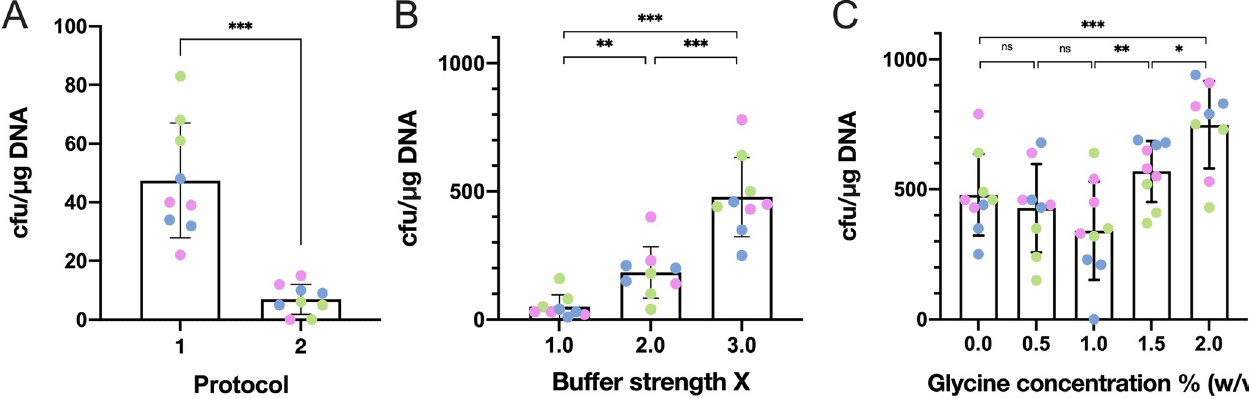
Fig 2. Optimization of competent cells preparation for L . jensenii ATCC25258 using pTRKH2. A. Comparison of widely used electroporation protocols for Lactobacillus spp . Shown are transformation efficiency of Lactobacillus jensenii observed using original protocols described by Luchansky et al. (protocol 1) [22] and Berthier et al. (protocol 2) [21]. B. Increasing buffer concentration improves transformation efficiency. Shown are transformation efficiency of electrocompetent L . jensenii prepared at 1, 2 or 3X the concentration described in Luchansky et al. [16]. More concentrated buffers led to arcing. C. Addition of glycine improves transformability. Shown are transformation efficiency of electrocompetent L . jensenii prepared in 3X buffer with increasing titers of glycine (expressed as weight to volume percentage). Titers higher than 2.0% lead to markedly reduced growth rate. All electroporation were performed with 1 μ g pTRKH2 in 0.1 cm electroporation cuvettes and electric parameters as follows: voltage: 6.5 kV/cm, resistance: 600 Ohm, capacitance: 25 μ F. 3 biological replicates of 3 technical replicates were performed on different days (data are shown in S2 Table). Technical replicates are shown in the same color. (Wilcoxon signed-rank test p-value, ns p > 0.05, � p < = 0.05, �� p < = 0.01, ��� p < = 0.001 and ���� p < = 0.0001).